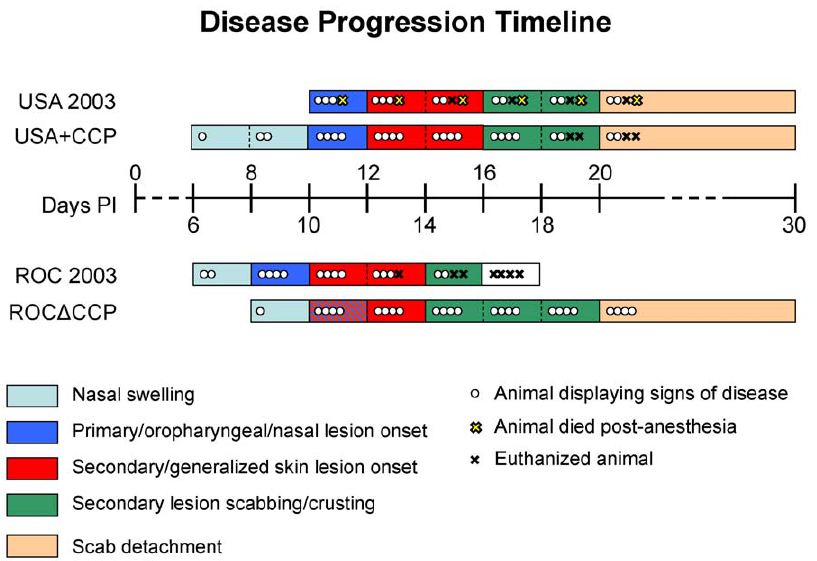
Figure 5. Monkeypox disease progression timeline. Depiction of the comparative disease progression of the four challenge monkeypox strains in the prairie dog animal model. This diagram highlights monkeypox disease as observed lesions progressed from a local to systemic infection and eventual resolution. Note the slower progression of disease in the ROC D CCP-infected group when compared to its ROC 2003 parental group. The USA + CCP-infected prairie dogs displayed earlier subjective signs of infection when compared to the USA 2003